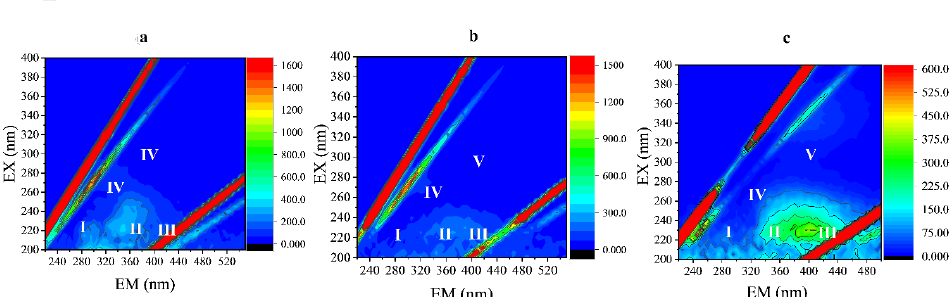
Figure 2. Fluorescence excitation–emission matrixes (EEM) of the selected samples and cleaning